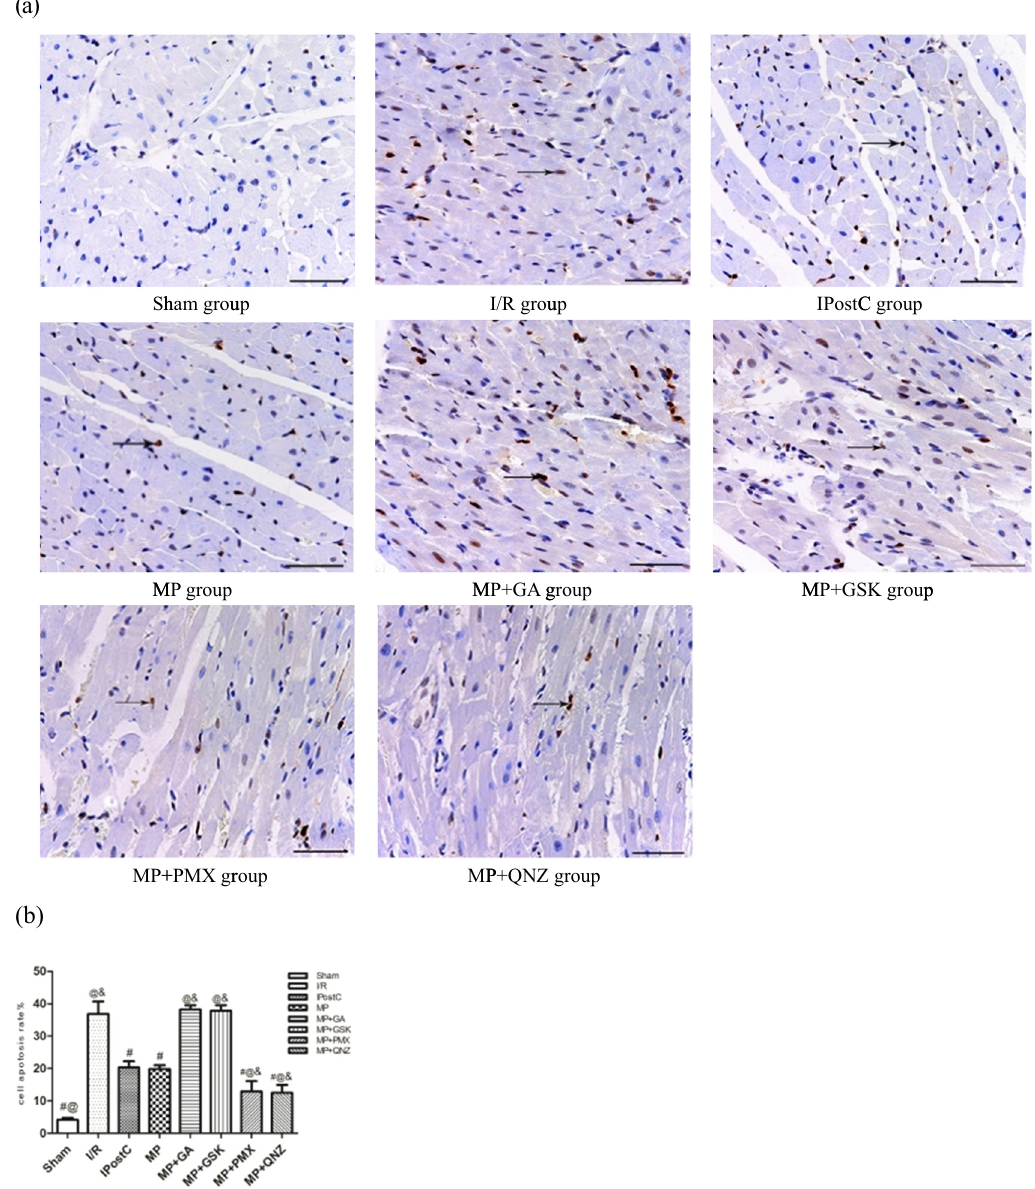
Figure 2: ( a ) E ff ects of IPostC, MP, and MP with treatment with the GA, GSK, PMX, and QNZ on apoptosis after myocardial I/R. ( b ) Quantitative analysis of cell apoptotic rate, results presented in a bar graph are mean ± standard deviation. Apoptotic cardiomyocyte nuclei appear brown stained, whereas TUNEL - negative nuclei appear blue. Arrow indicates TUNEL - positive cells. TUNEL stain × 400, all bars = 50 μ m. # P < 0.05 vs I/R group; @ P < 0.05 vs IPostC group; & P < 0.05 vs MP group, n = 5 for each group. I/R: ischemia/reperfusion; MP: morphine postconditioning; GA: geldanamycin; GSK: GSK - 690693; PMX: PMX 205; QNZ: